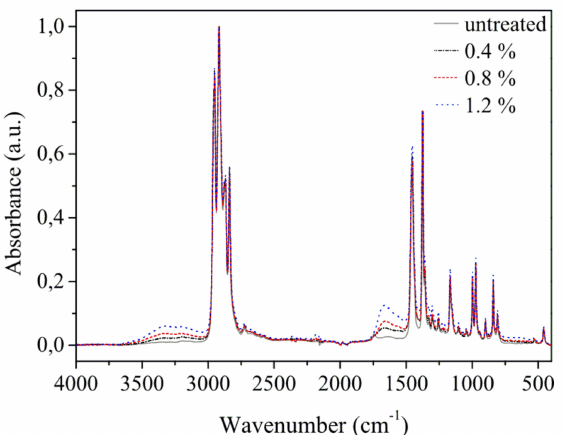
Figure 6. Infrared spectrum of untreated and plasma-treated samples for varied compositions of processing gas, i.e., 0.4, 0.8, and 1.2% of P-B in nitrogen. A treatment time of 15 seconds was kept in all cases.